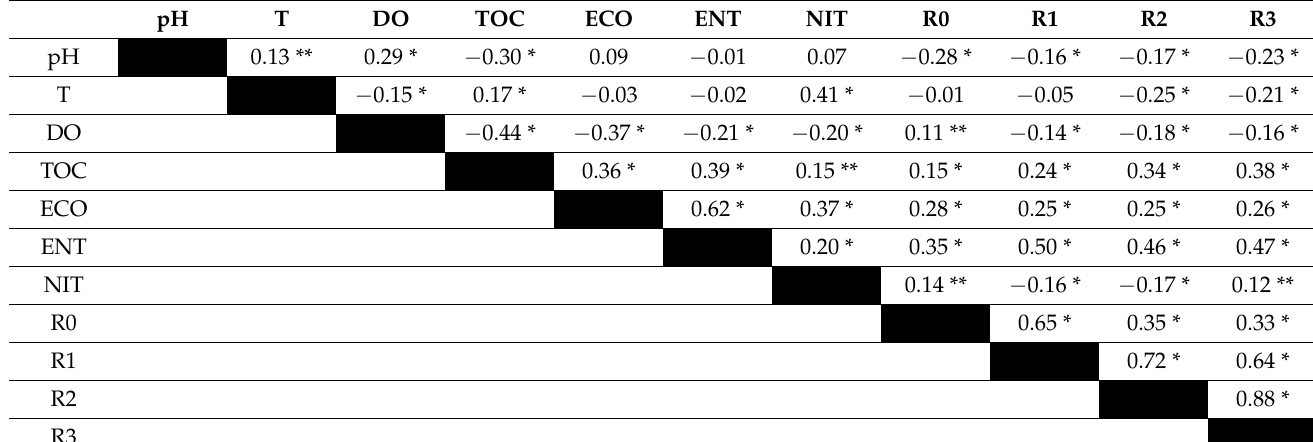
Table A3. Spearman’s rank correlation coefficient r s . * p < 0.01, ** p < 0.05.